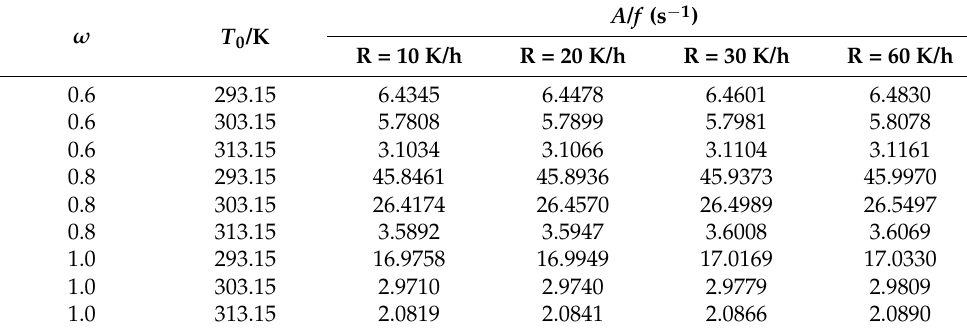
Table 5. Nucleation parameter A / f fitted by the Sangwal